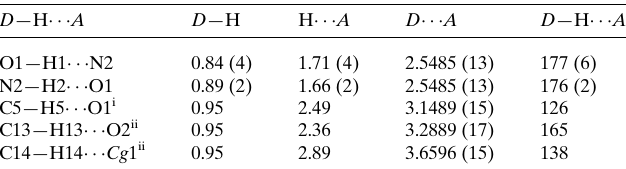
Table 4 Hydrogen-bond geometry (A˚ , (cid:4) ) for (III). Cg 1 is the centroid of the C1–C6 ring.